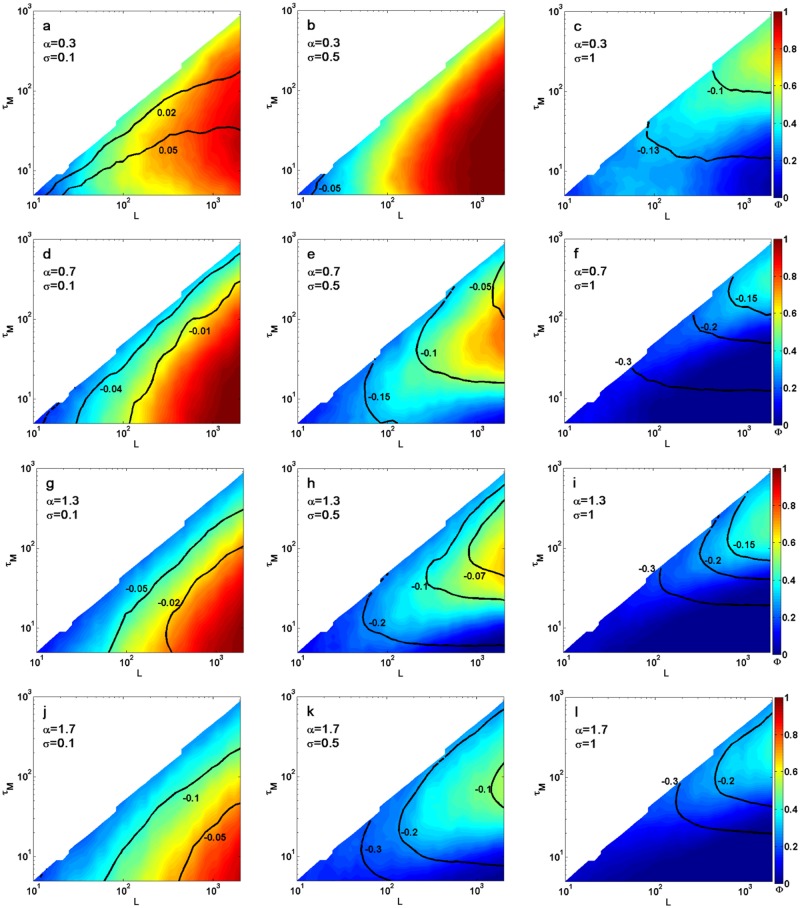
Performance of the time averaged MSD estimator for various trajectory lengths L and maximal time lags τ
M.Color bar gives the precision Φ and black lines give representative bias values, B. Rows give various anomalous exponents with (a–c) strong subdiffusion α = 0.3, (d–f) weak subdiffusion α = 0.7, (g–i) weak superdiffusion α = 1.3 and (j–l) strong superdiffusion α = 1.7. Measurement error changes between columns with (left) small error σ = 0.1, (middle) medium error σ = 0.5 and large error σ = 1. The optimal τ
M is selected as the area where Φ is maximal and ∣B∣ is minimal for a given trajectory length L.